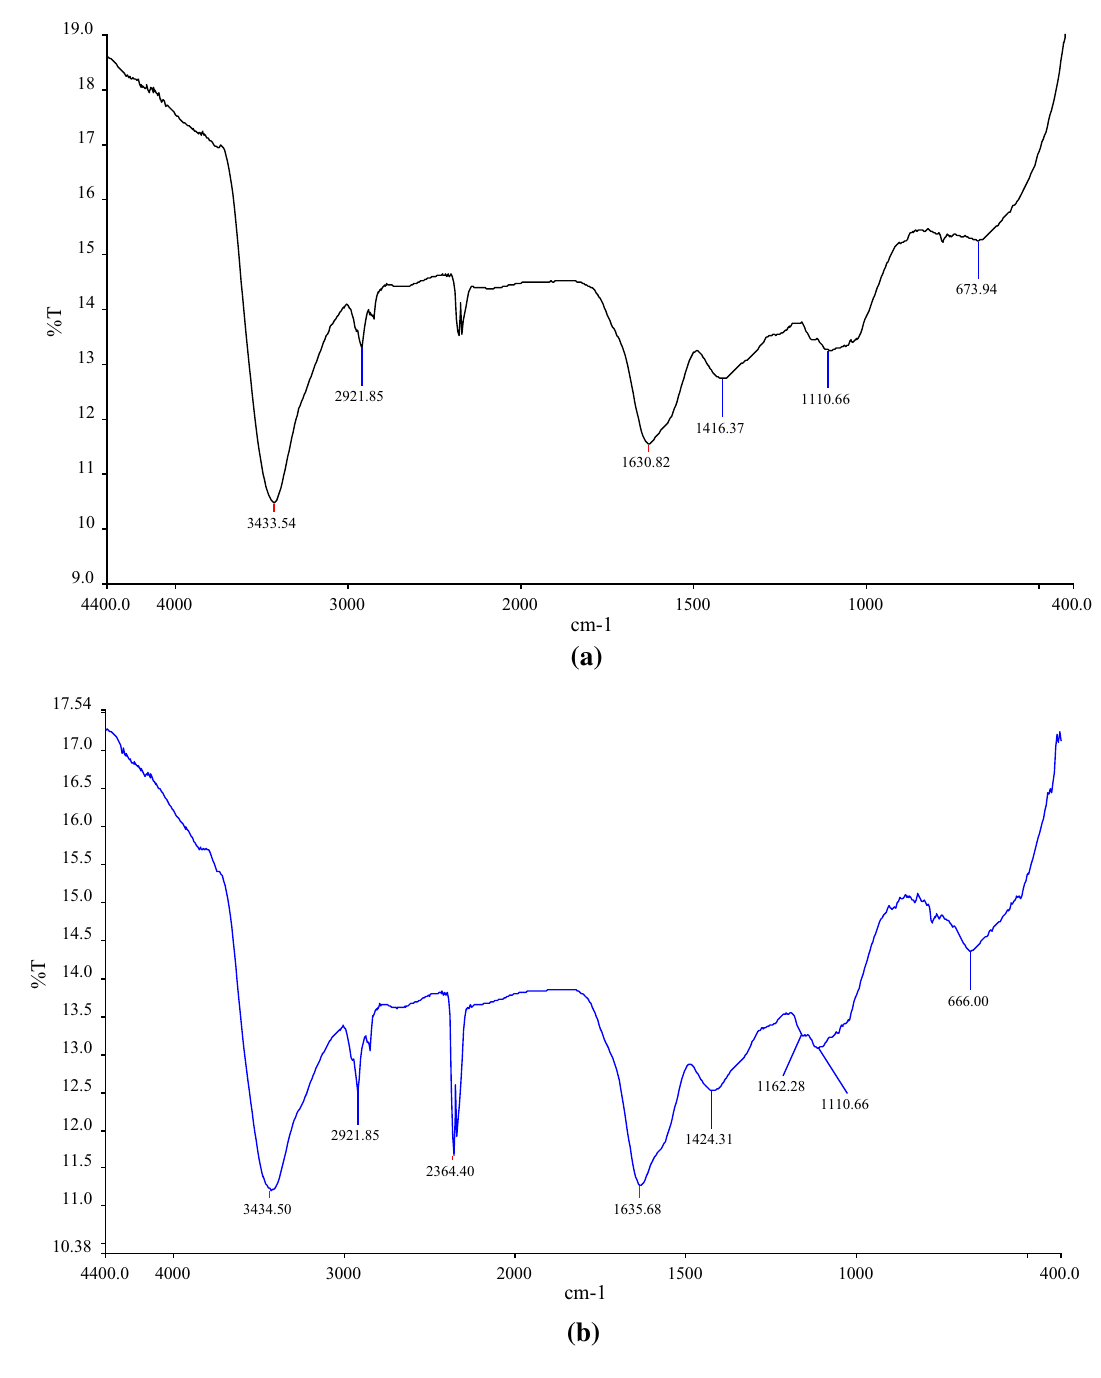
Fig. 2 FTIR spectra of BP a before and b after Congo red adsorption by banana